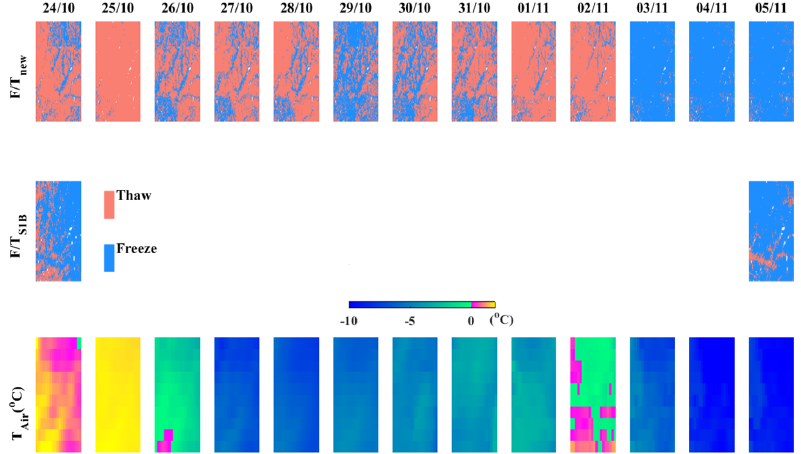
Figure 13. Time series of F/T new (first line), F/T S1B (second line) and air temperature over the Genhe watershed area from 24 October 2018 to 5 November 2018.